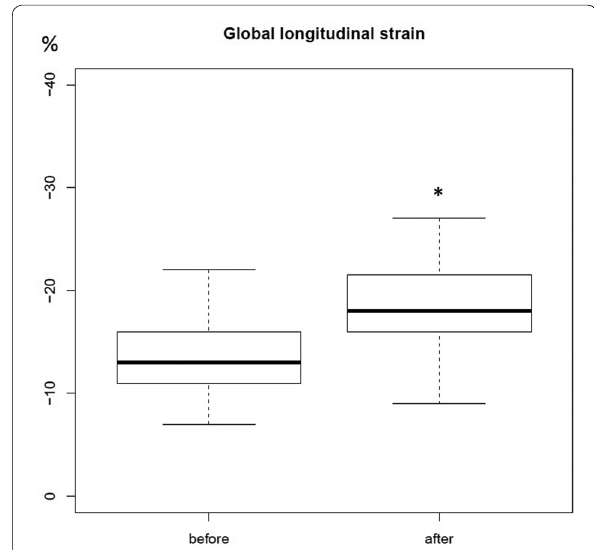
Fig. 2 Significant increase of cardiac index before and after fluid challenge 2.4